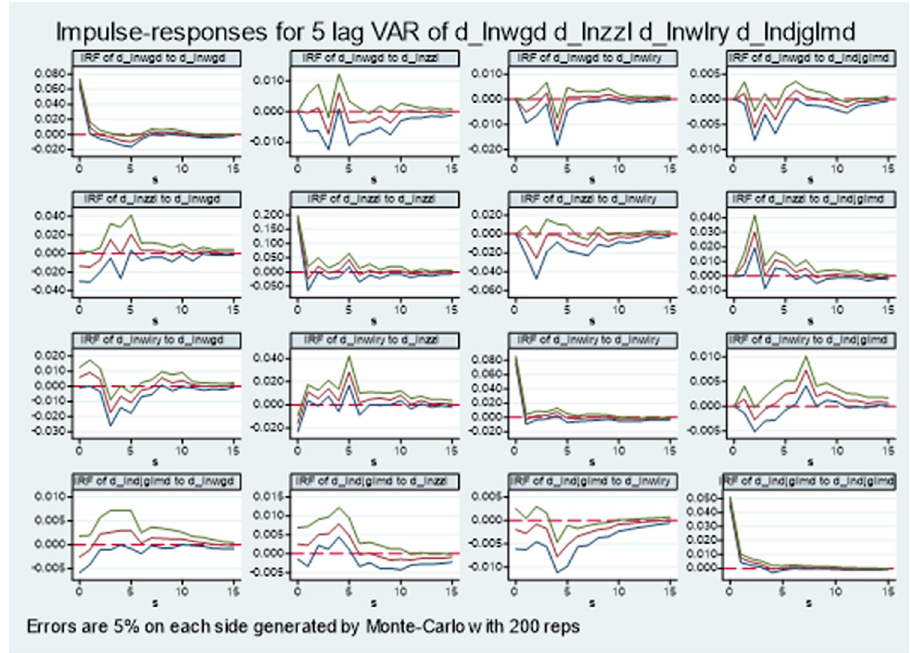
Fig 4. Impulse response diagram of logistics industry and the efficiency of